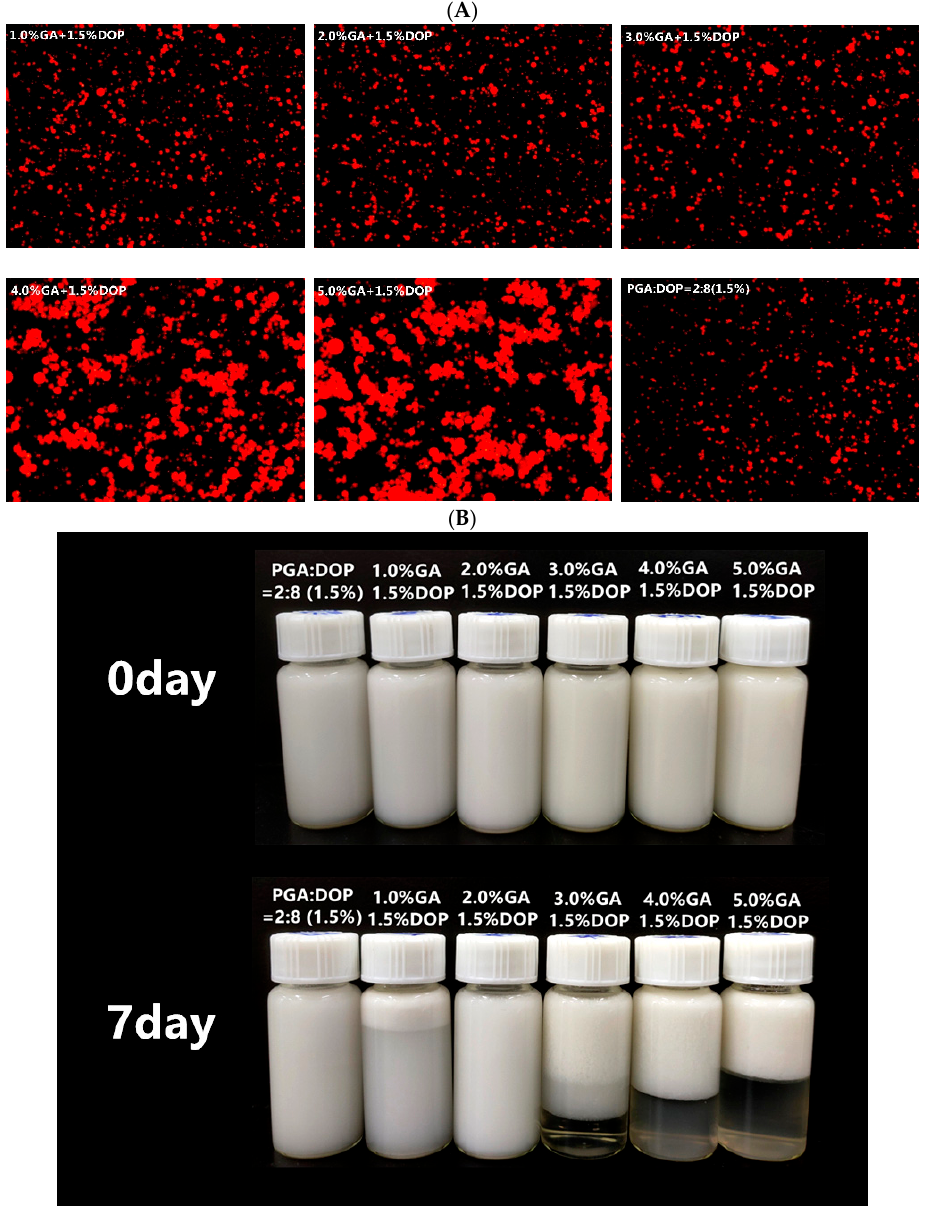
Figure 8. ( A ): The microstructure of emulsions (secondary screening of the concentration and ratio of compound polysaccharide emulsifiers); ( B ) The visual observations of emulsions (secondary screening of the concentration and ratio of compound polysaccharide emulsifiers).